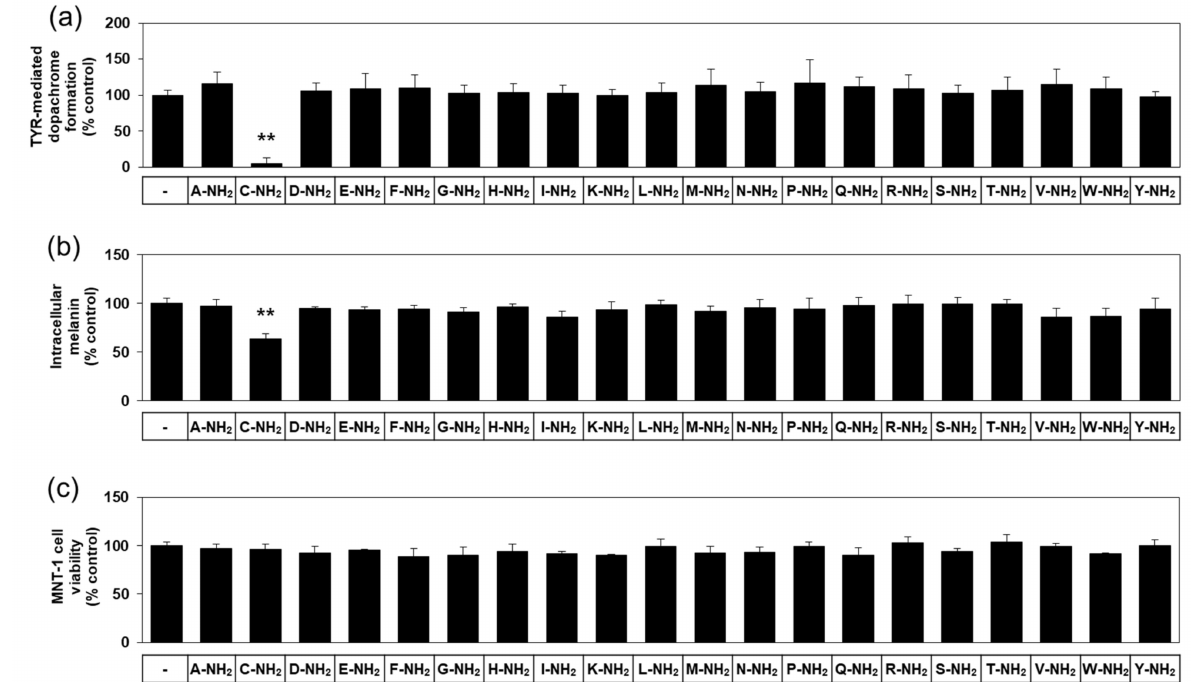
Figure 1. Effects of twenty different amidated amino acids on tyrosinase (TYR)-mediated dopachrome formation in vitro, and the eumelanin content and viability of MNT-1 cells. In ( a ), TYR-mediated dopachrome formation was determined using a lysate of human embryonic kidney 293 cells constitutively expressing human TYR in the absence (the control) or presence of each substance at 0.2 mM. Data are presented as % of control (means ± SD, n = 4). ** p < 0.01 vs. control. In ( b ) and ( c ), MNT-1 cells were treated with vehicle (control) or each substance at 0.5 mM for 72 h. Melanin content ( b ) and cell viability ( c ) are presented as % of control (means ± SD, n = 4). ** p < 0.01 vs.